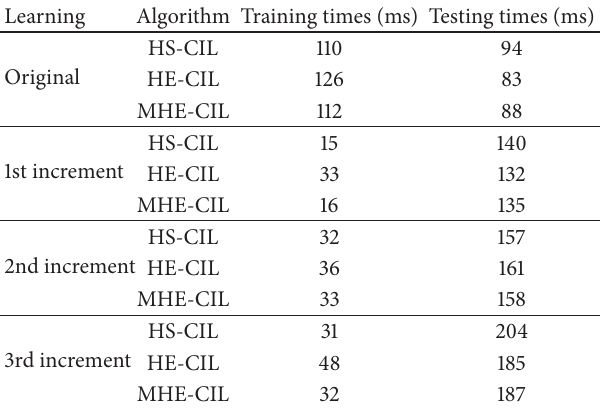
Table 3: The comparison of training time and testing time.